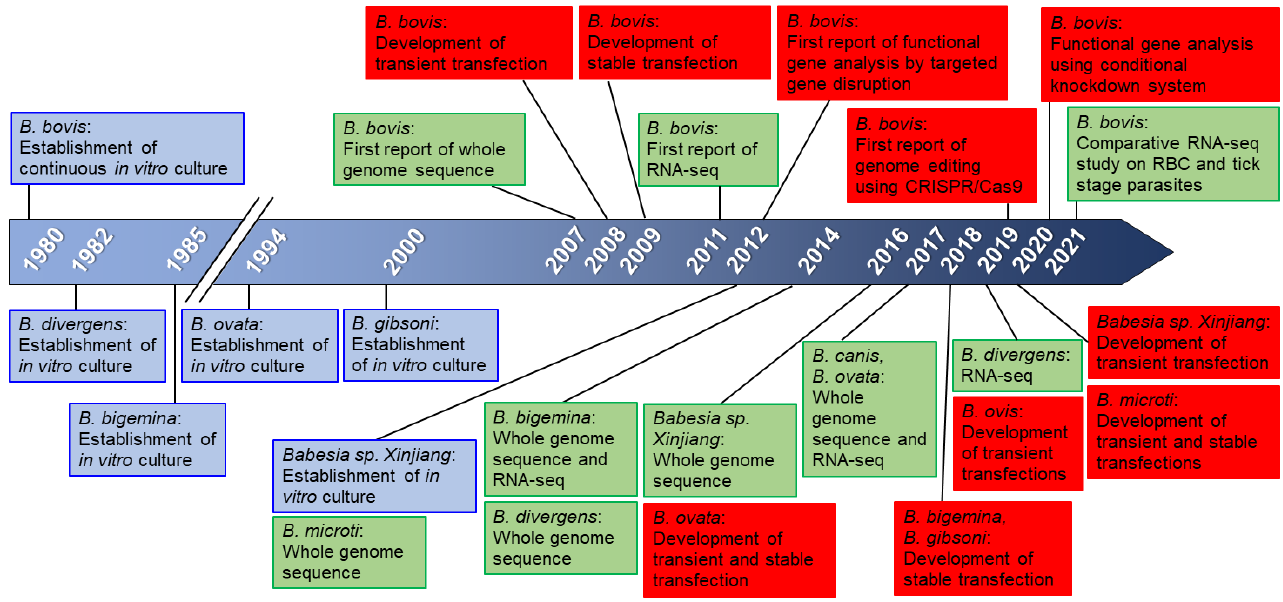
Figure 2. Establishment of in vitro culture, release of genome and transcriptome sequences, and development of genetic tools for Babesia. The development of in vitro culture (blue box), release of the whole genome and transcriptome sequences (green box), genetic tools (red box) are shown in chronological order.